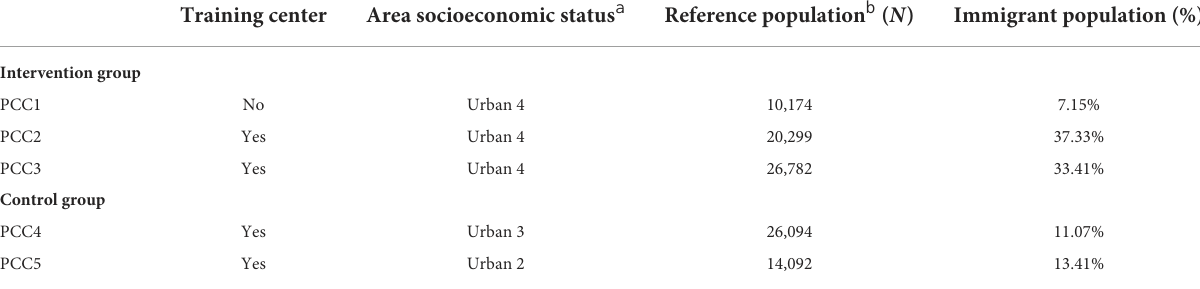
TABLE 1 Characteristics of the PC centers.